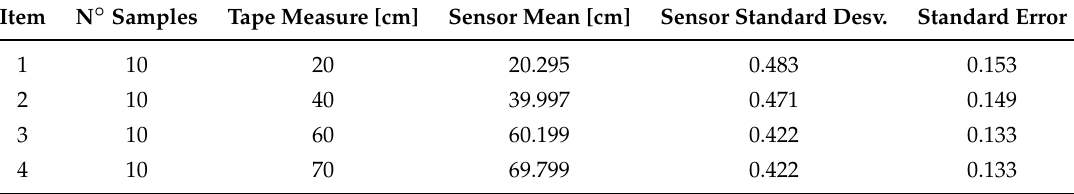
Table 2. Measurements taken on